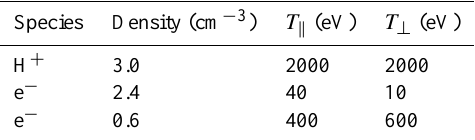
Table 2. The second plasma model. All components are assumed to be Maxwellians. The model is based on PEACE and CIS observa- tions. Compared to Model 1, we assume slightly less cold electrons and introduce an inverse temperature anisotropy at higher energies.